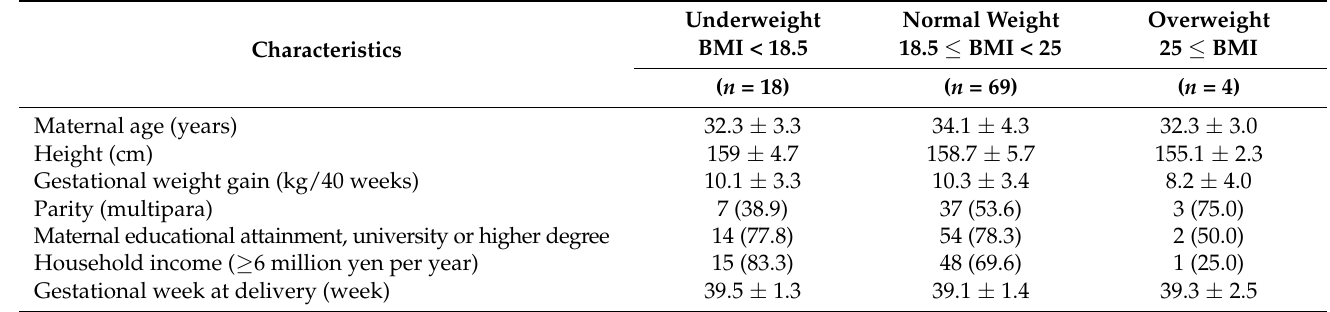
Table 1. Maternal characteristics according to pre-pregnancy BMI category of BC-GENIST (2015–2019) participants with no misreported energy intake.